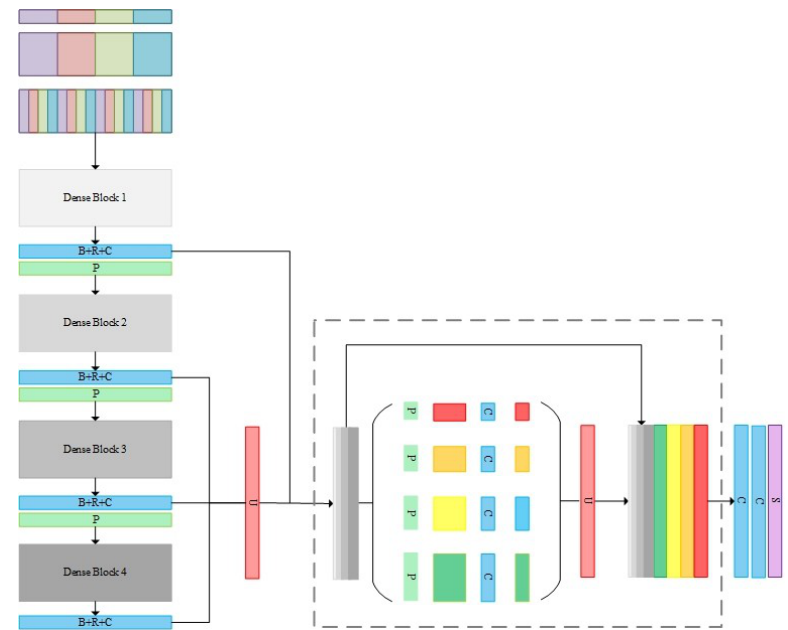
Figure 2. Architecture of the proposed dense pyramid network. B + R + C: Batch normalization + Rectified Linear Unit (ReLU) + Convolutional layer (kernel size: 1 × 1, stride: 1), where P: Pooling layer (kernel size: 2 × 2, stride: 2); U: Upsamling layer; C: Convolutional layer (kernel size: 3 × 3, stride: 1); S: Softmax layer.